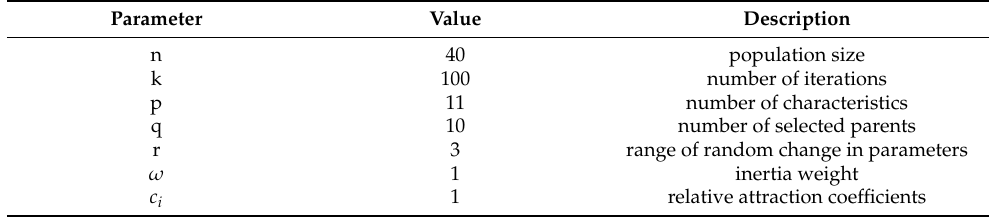
Table 2. Algorithm’s